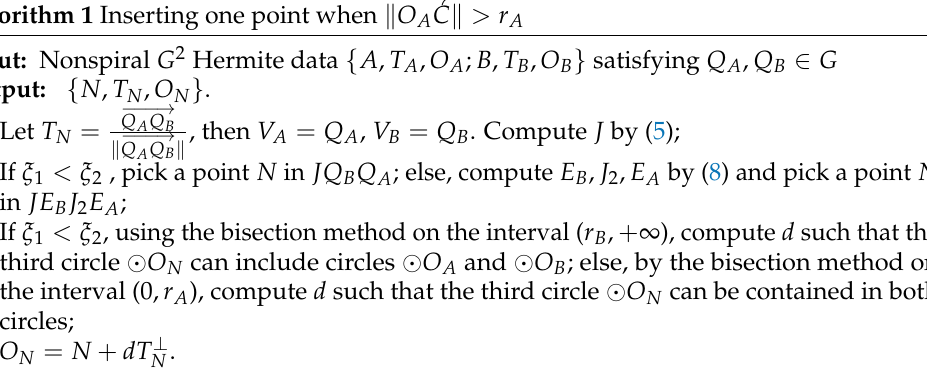
Algorithm 1 Inserting one point when